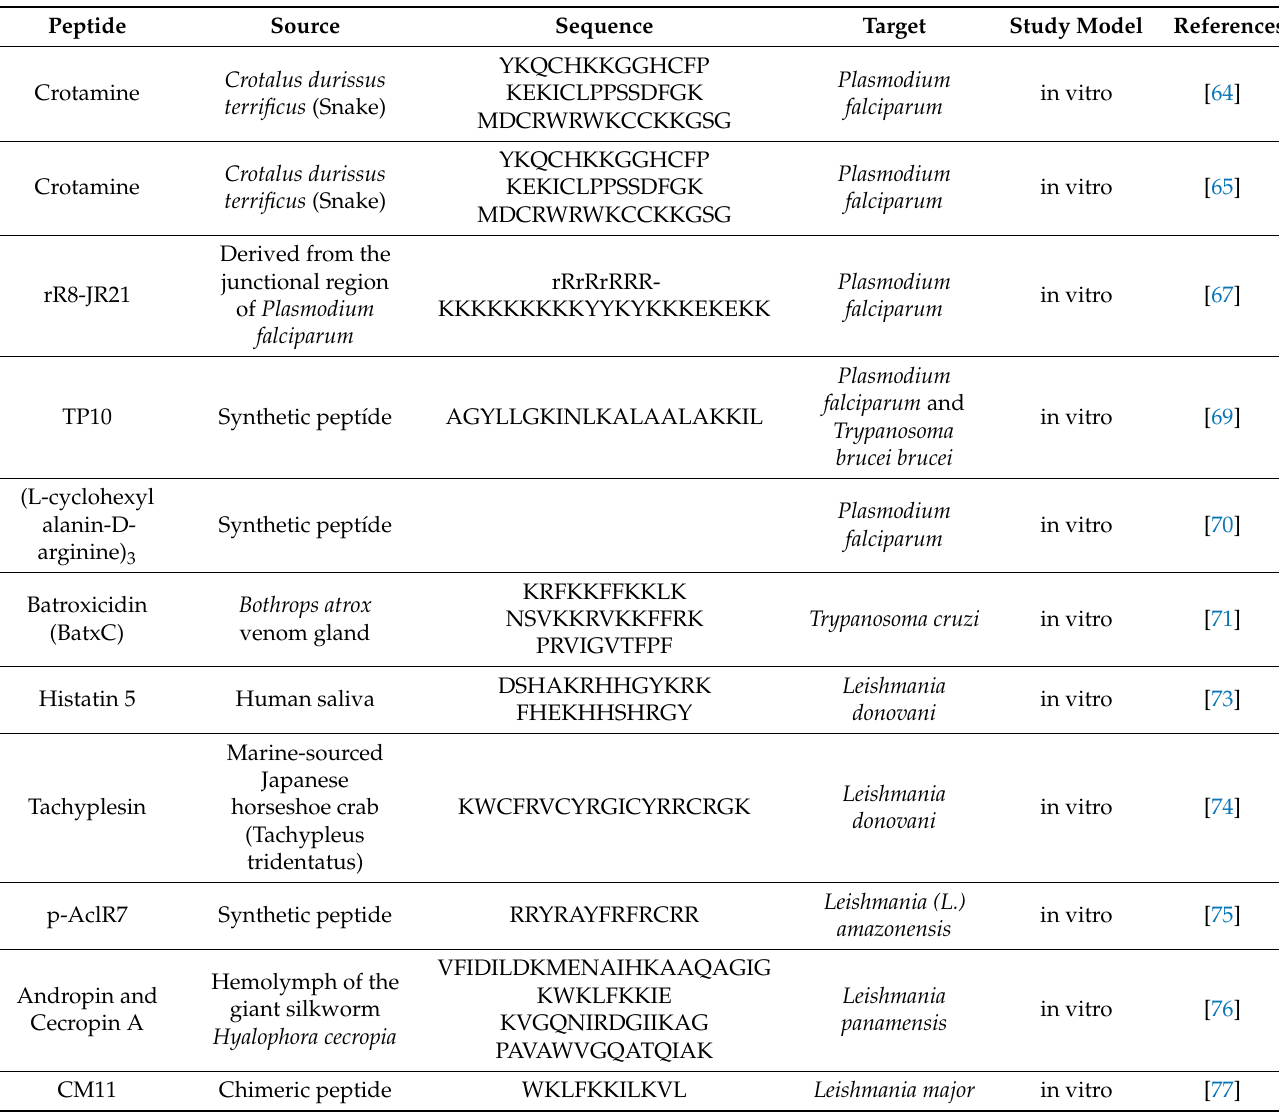
Table 3. Cell-penetrating antimicrobial peptides against intracellular